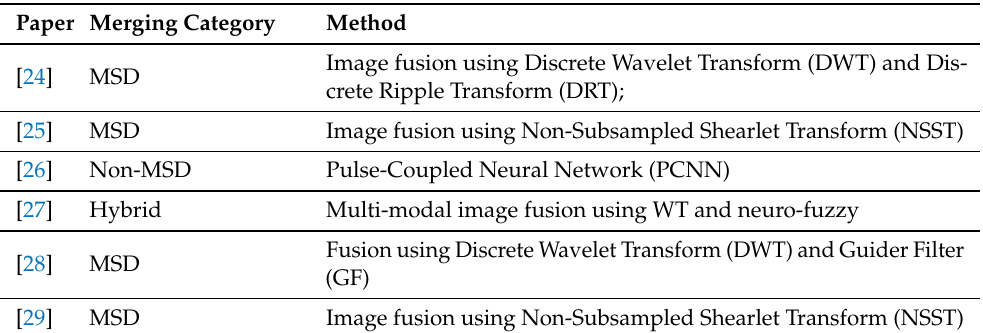
Table 4. Articles about multi-modal image